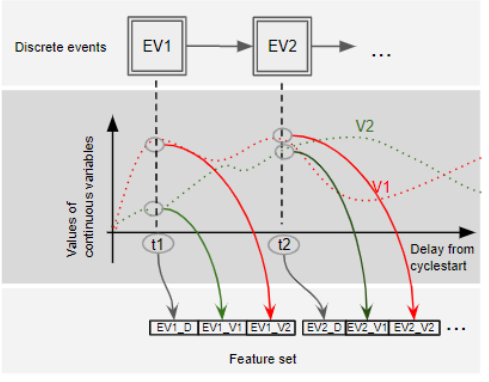
Figure 2. Feature set preparation process to combine discrete events and continuous